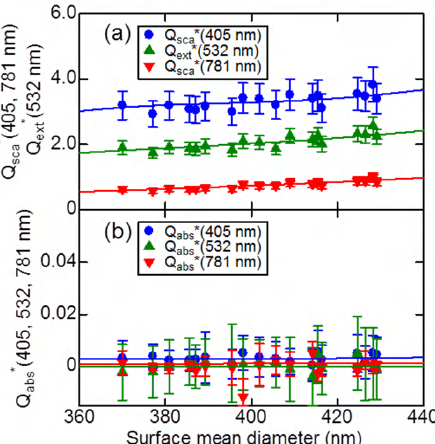
857 Figure 4. Dependence of the effective (a) scattering (or extinction) and (b) absorption 858 Fig. 4. Dependence of the effective (a) scattering (or extinction) efficiencies of the polydisperse SOA particles on the surface mean diameter at wavelengths of 859 and (b) absorption efficiencies of the polydisperse SOA particles on 405 (circles), 532 (triangles), and 781 nm (inverted triangles) for the 1,3,5-TMB-SOAs 860 the surface mean diameter at wavelengths of 405 (circles), 532 (tri- generated in “run B1”. The symbols are the same as those used in Fig. 3. 861 angles), and 781nm (inverted triangles) for the 1,3,5-TMB-SOAs generated in “run B1”. The symbols are the same as those used in Fig. 3.